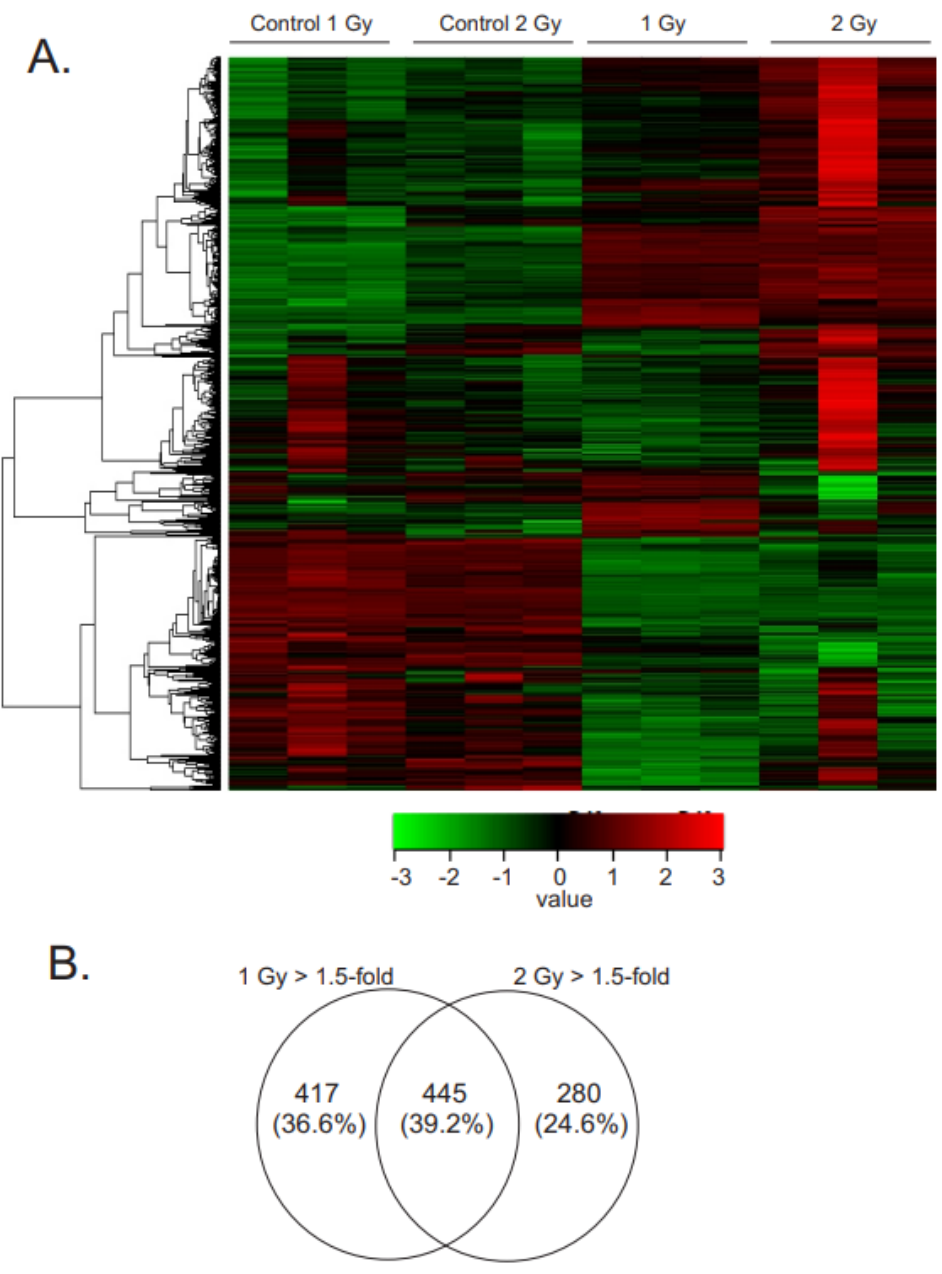
Figure 2. Gene expression changes in irradiated MSCs. MSCs were grown to 60% confluence and exposed to 60 Co irradiation at 0.66 cGy/h for 1 Gy (1 week) or 2 Gy (2 weeks). Control cells were cultured under identical conditions for each time point. RNAseq was performed using N = 3 samples for each condition. ( A ). Heat map indicates gene expression patterns following radiation exposure. ( B ). Venn diagram illustrating the number of genes with altered expression at each time point, q < 0.05, absolute fold change >1.5.